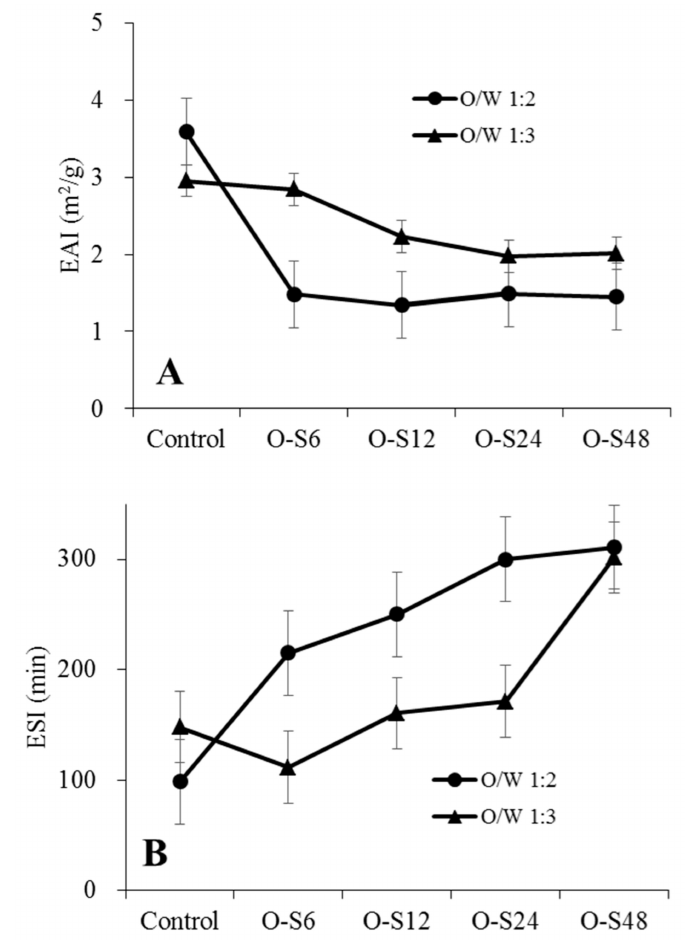
Figure 5. Emulsifying activity index (EAI) ( A ) and emulsion stability index (ESI) ( B ) of Pickering emulsions stabilized by ODF-SPI mixture (control) and ODF-SPI conjugates by dry heating at 60 ◦ C for 6 h (O-S6), 12 h (O-S12), 24 h (O-S24) and 48 h